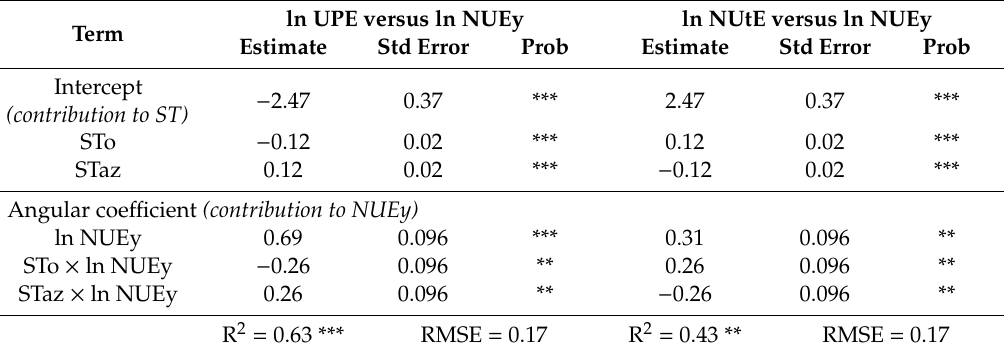
Table 8. E ff ect of strobilurin treatment on nitrogen uptake e ffi ciency (UPE) and nitrogen utilization e ffi ciency (NUtE) contribution to nitrogen use e ffi ciency for yield (NUEy) in the cultivar